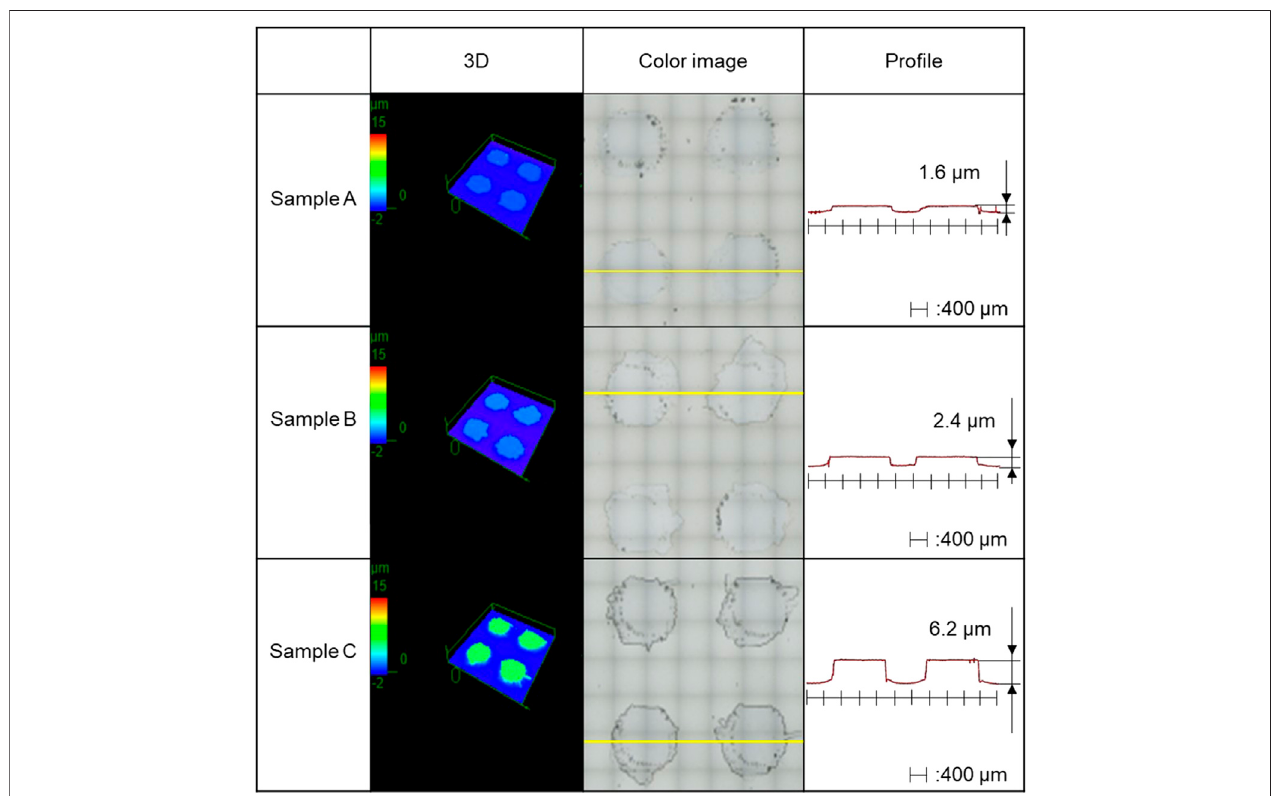
FIGURE 6 | 3D map, color image, and pro fi le of the glass surface after the removal of the sacri fi cal pattern.